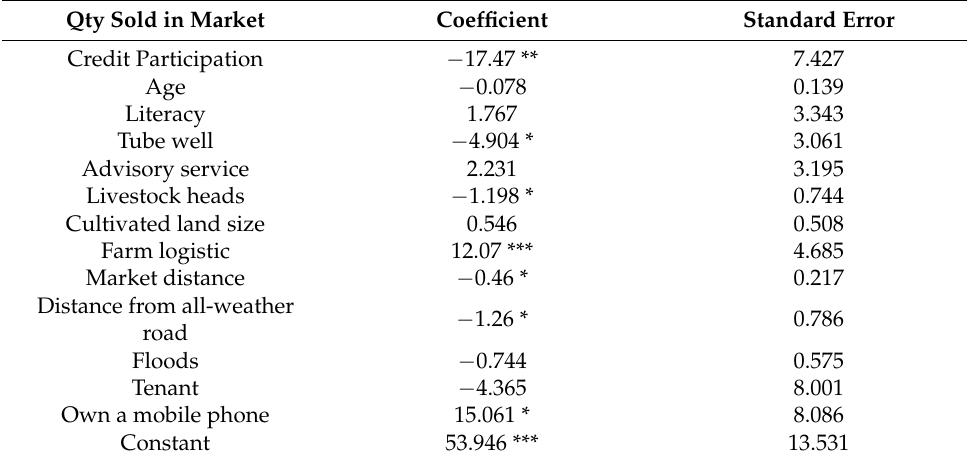
Table A2. Full table of IV estimate of first-period credit and market